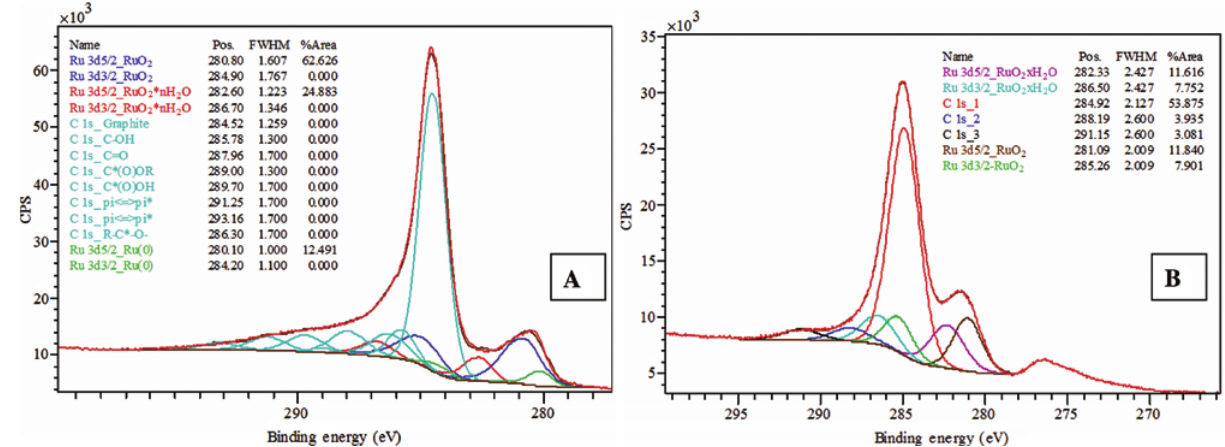
Figure 4: High resolution spectra of Ru 3d and C 1s sublevels for (A) 5%-Ru/C-H